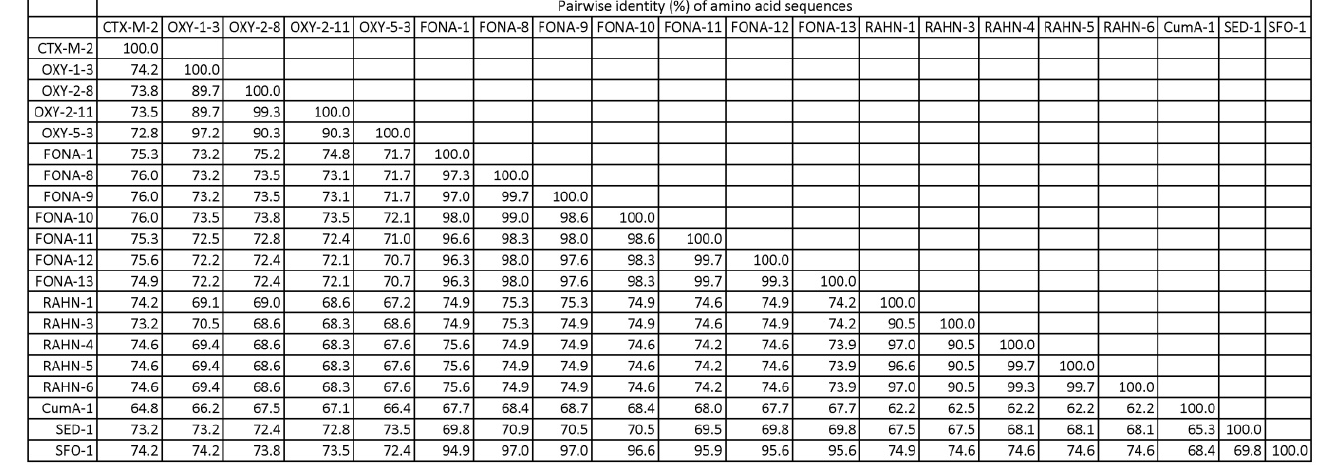
Figure 1. Distance matrix of amino acid sequences of CTX ‐ M ‐ 2 and CTX ‐ M ‐ like β‐ lactamases. CTX ‐ M β‐ lactamase detection was performed on positive aerobic blood culture bottles which were spiked with the isolates. The NG ‐ Test CTX ‐ M MULTI detected 100% of all CTX ‐ M alleles from the M1 group (1, 15 and 55), M9 group (13, 14, 27, 65 and 191) and hybrid group (64, 123 and 132). Among the CTX ‐ M ‐ like enzymes, positive CTX ‐ M result was obtained in 5 of 27 spiked bottles (Table 1). The isolates were producers of OXY ‐ 1 ‐ 3 ( n = 1), OXY ‐ 5 ‐ 3 ( n = 1), FONA ‐ 10 ( n = 2) and SFO ‐ 1 ( n = 1). The 28 isolates with CTX ‐ M ‐ like enzymes were further tested using colonies from culture growth on blood agar plates. Positive CTX ‐ M results were obtained for the 5 isolates that yielded a positive result from the spiked blood cultures. In addition, a positive CTX ‐ M result was obtained for another 7 isolates with OXY ‐ 2 ‐ 8 ( n = 1), FONA ‐ 8 ( n = 1), FONA ‐ 9 ( n = 2), FONA ‐ 11 ( n = 1) and FONA ‐ 13 ( n = 2) (Figure 2).